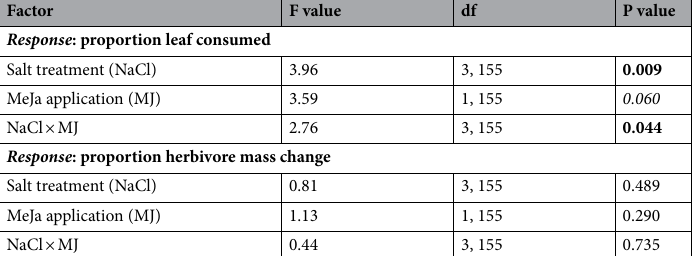
Table 1. Results from linear mixed models testing for the effect of salt treatment in the soil, Methyl Jasmonate (MeJa) application and their interaction on feeding consumption (proportion of leaf consumed) and performance (proportion of herbivore mass change) of the generalist herbivore Spodoptera exigua on tomato ( Solanum lycoperscium ) plants in laboratory feeding